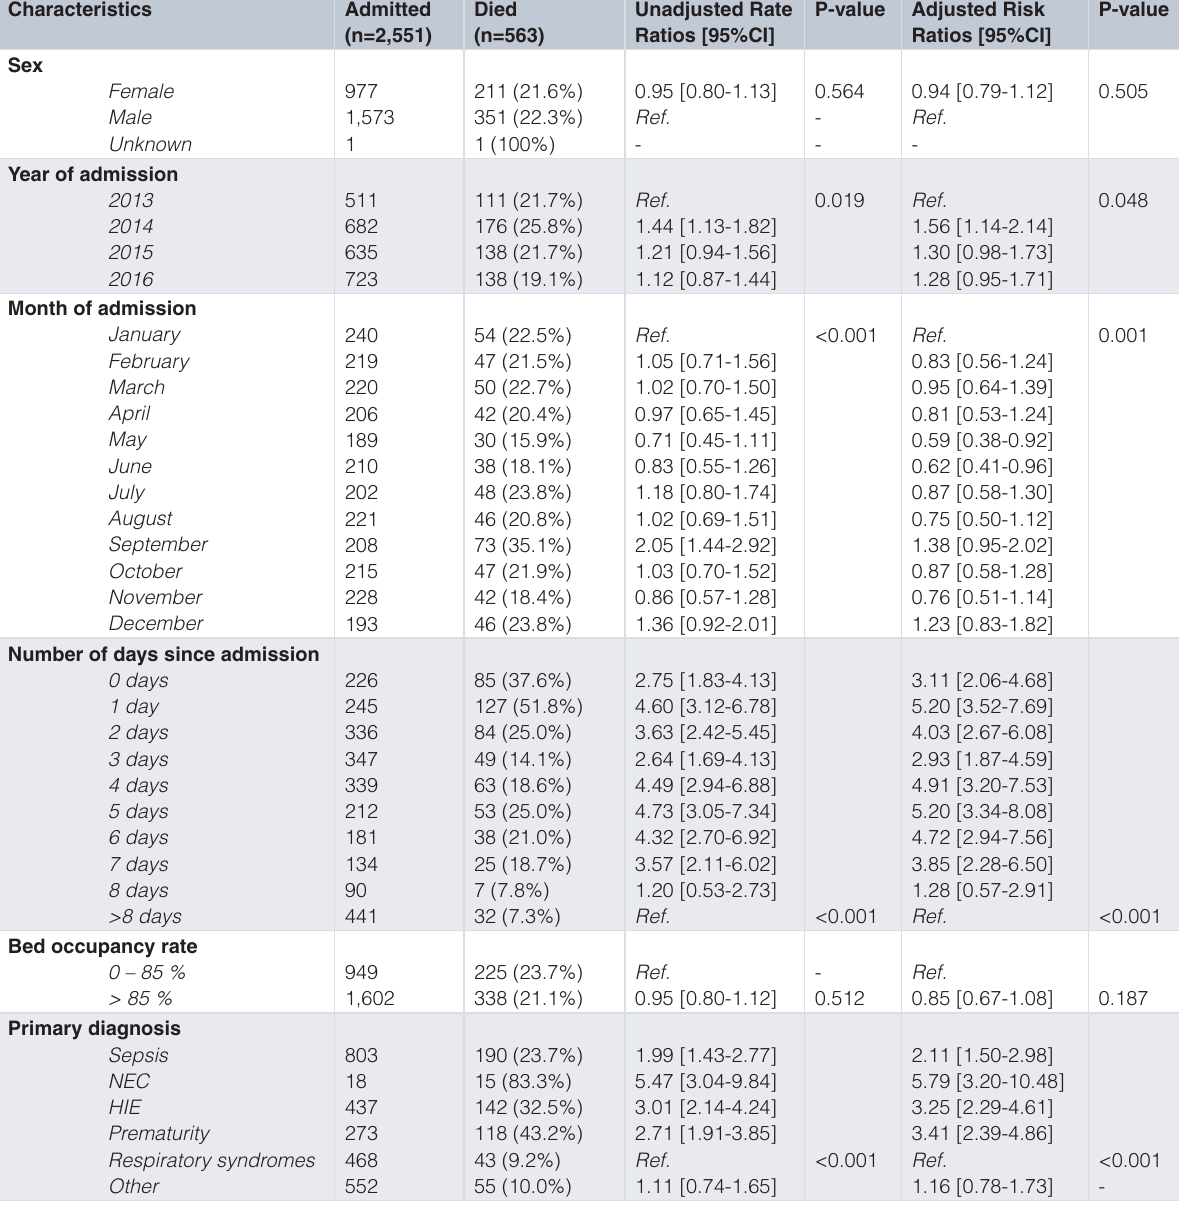
Table 1. Patient characteristics and analysis results of the infants (<7 months) who were admitted between 2013 and 2016 in the Inpatient Department (IPD) of Chaman. Characteristics